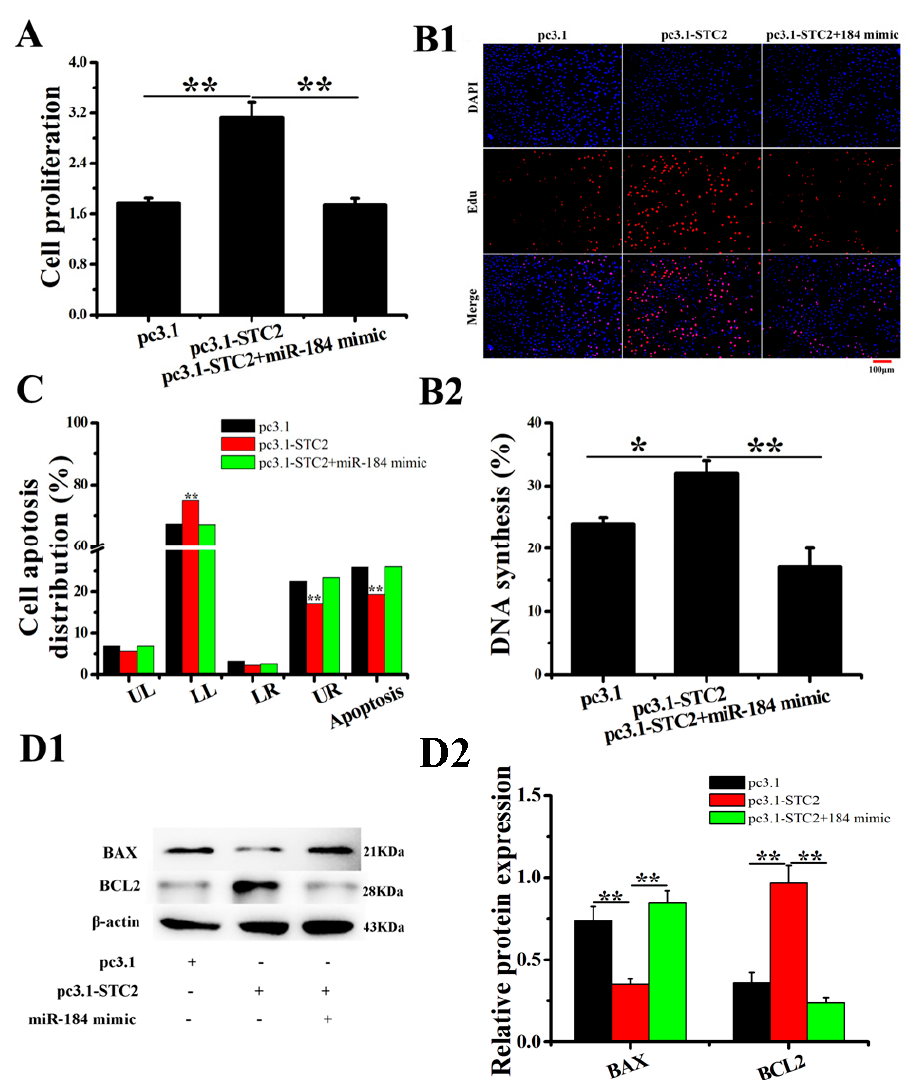
Figure 4. Overexpression of STC2 inhibited the EECs apoptosis in vitro. ( A ) pc3.1-STC2 and / or miR-184 mimics were transfected into EECs, and CCK-8 was used to detect cell viability. ( B1 , B2 ) Cell proliferation indices were assessed after treatment with EDU. The scale bar is 100 µ m. ( C ) FCM was used to detect apoptosis. ( D1 , D2 ) The WB analysis revealed the expression of BCL2 and BAX in EECs. The optical density method was normalized to the density of β -actin in the same lane. Data are expressed as the “mean ± SEM” of three values, ** p < 0.01; * p < 0.05. CCK-8, cell counting kit-8; WB, western blot; EDU, 5-Ethynyl-2 ′ -deoxyuridine; FCM, flow cytometry method; EECs, endometrial epithelial cell; SEM, standard error of the mean.